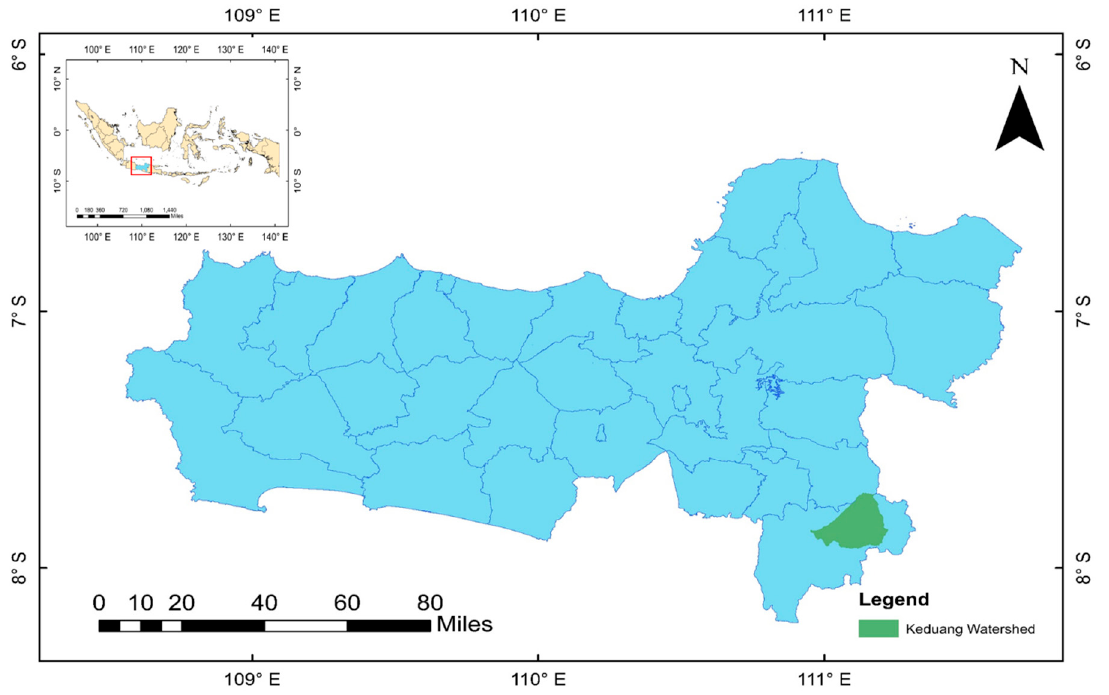
Figure 1. The study site for the rice production areas is Gemawang, Girimarto District, Wonogiri Regency, Central Java, Indonesia.